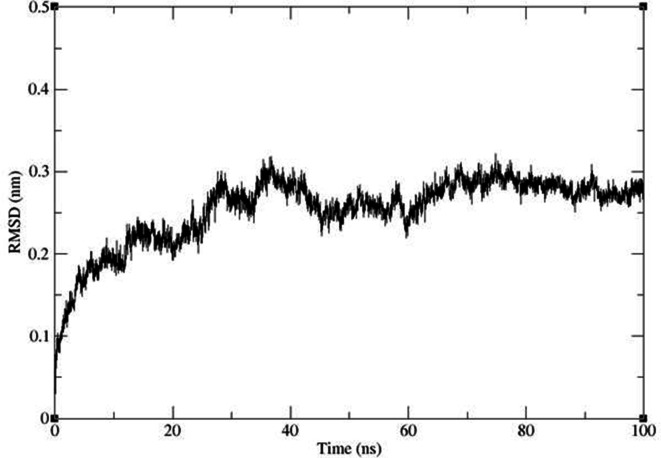
Backbone RMSD of the protein inserted into a lipid bilayer showing convergence to ~3 Å in a simulation of 100 ns length.